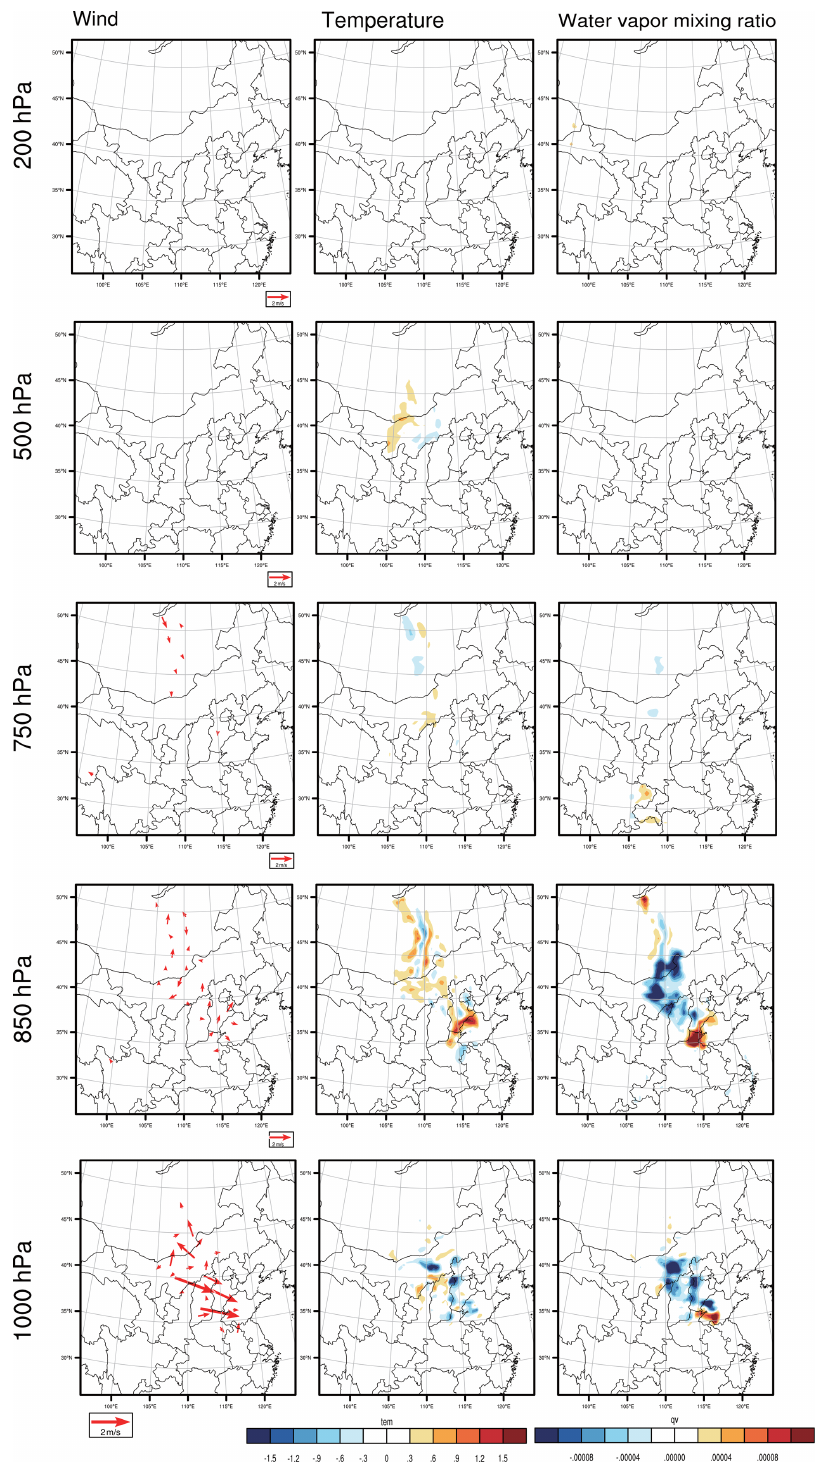
Figure 3. The horizontal distribution of the CNOP-type errors, including the wind component (vector, left column, ms − 1 ), temperature component (shaded, middle column, ◦ ) and water vapour mixing ratio component (shaded, right column, kgkg − 1 ) at an upper-pressure level (approximately 200hPa), middle-pressure level (approximately 500hPa), low-pressure level (approximately 850hPa) and ground level (approximately 1000hPa) for the forecast starting from 02:00BJT on 1 December, with a lead time of 24h.